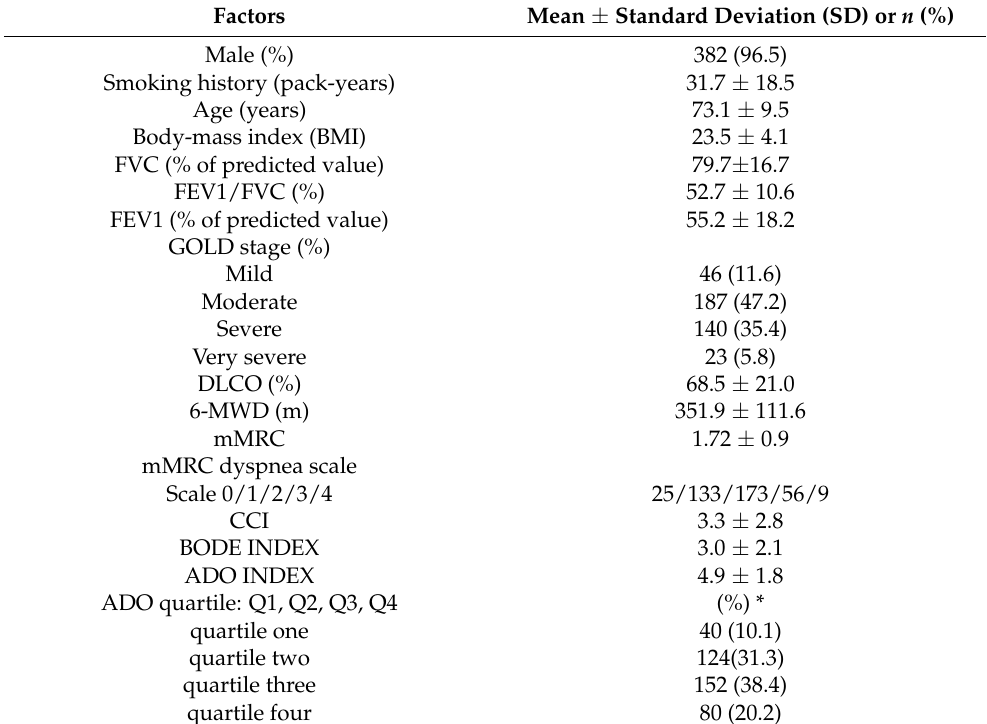
Table 2. Baseline characteristics of enrolled 396 chronic obstructive pulmonary disease (COPD)